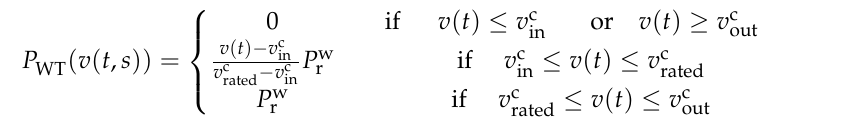
Figure 3. Signal flow diagram.